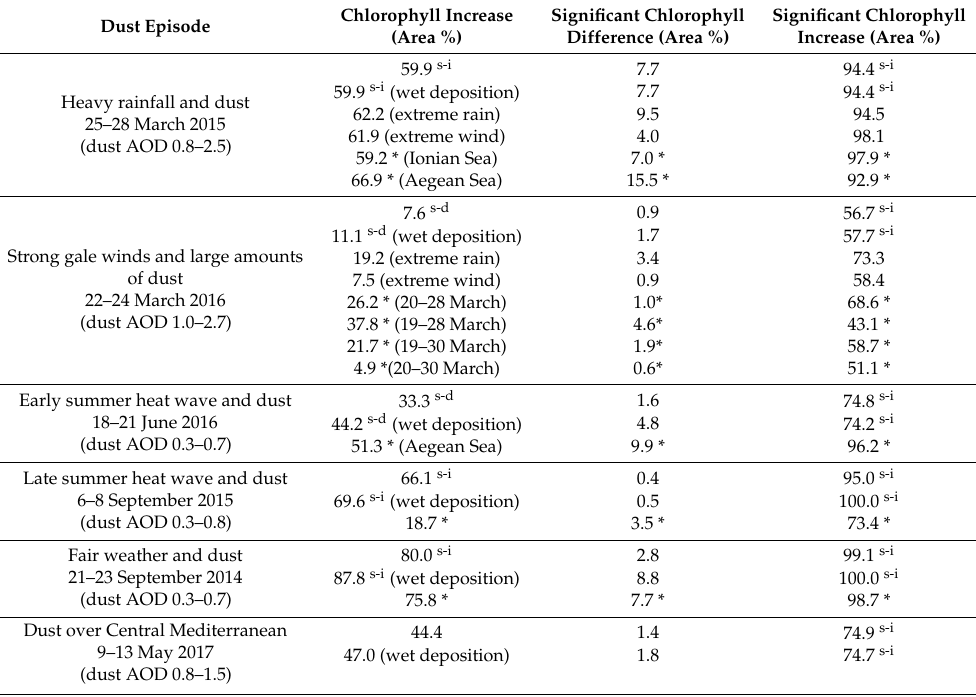
Table 1. The results of all calculations are summarized. The cases presenting statistically significant differences in the mean chlorophyll concentrations before and after the events, as derived by the weekly data, are marked with an “s” (s-i for increase and s-d for